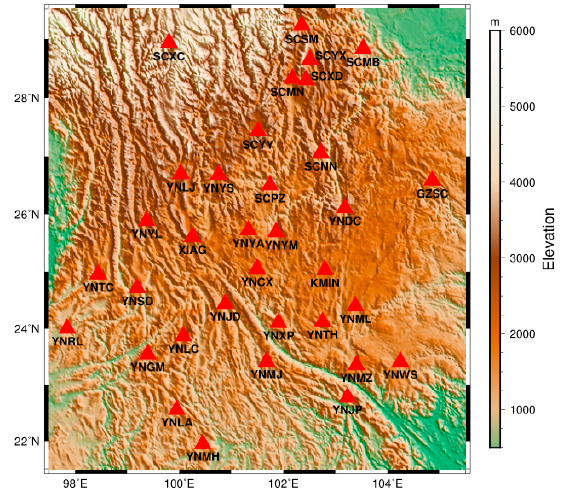
Figure 1. Topographic variations of southwest China with continuous global positioning system (GPS) station locations (in red).